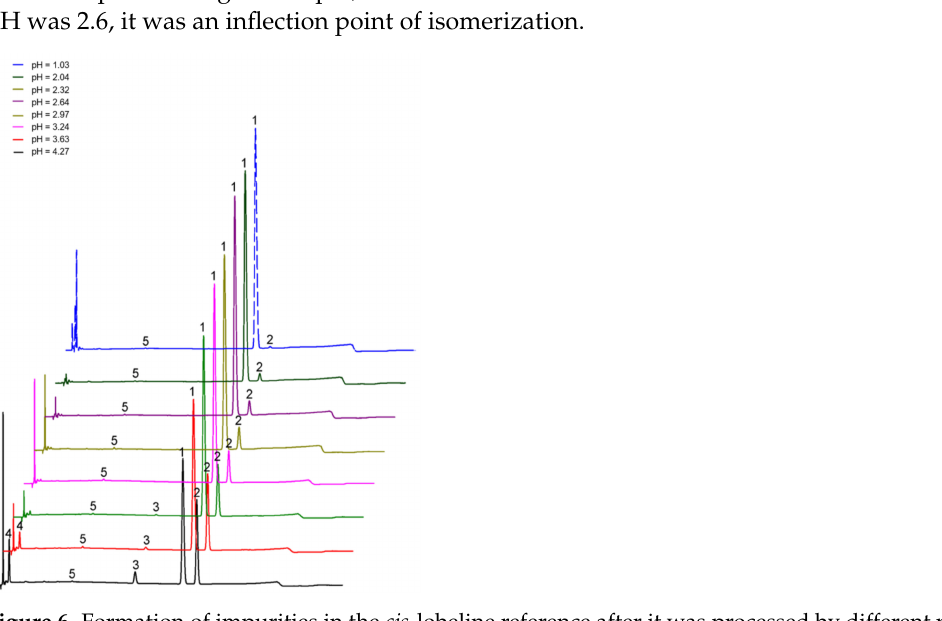
Figure 6. Formation of impurities in the cis -lobeline reference after it was processed by different pH solutions and autoclaving at 105 ◦ C for 15 min. 1 = cis -lobeline, 2 = trans -lobeline, 3 = Intermediate, 4 and 5 = unknown